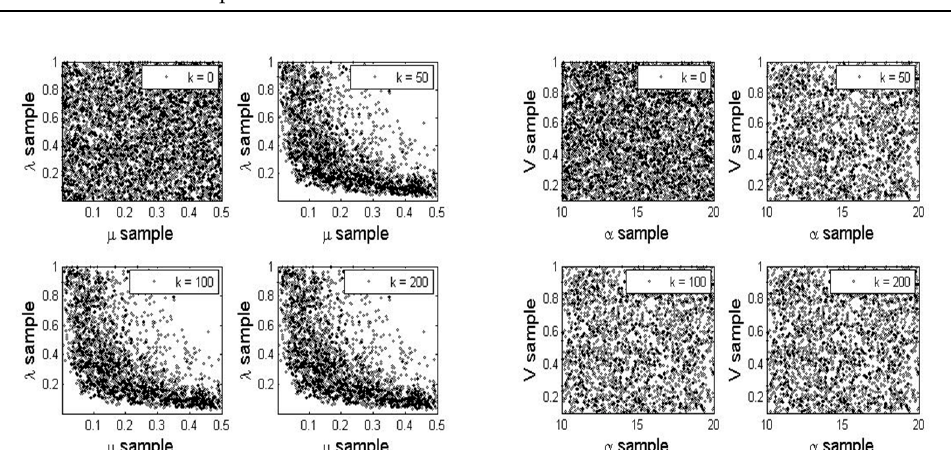
Figure 3. Real-time samples of the { λ , μ } and { ν , α }. Table 2. Cost Overrun Probability Comparison between Barraza et al. [32] and Our Model.